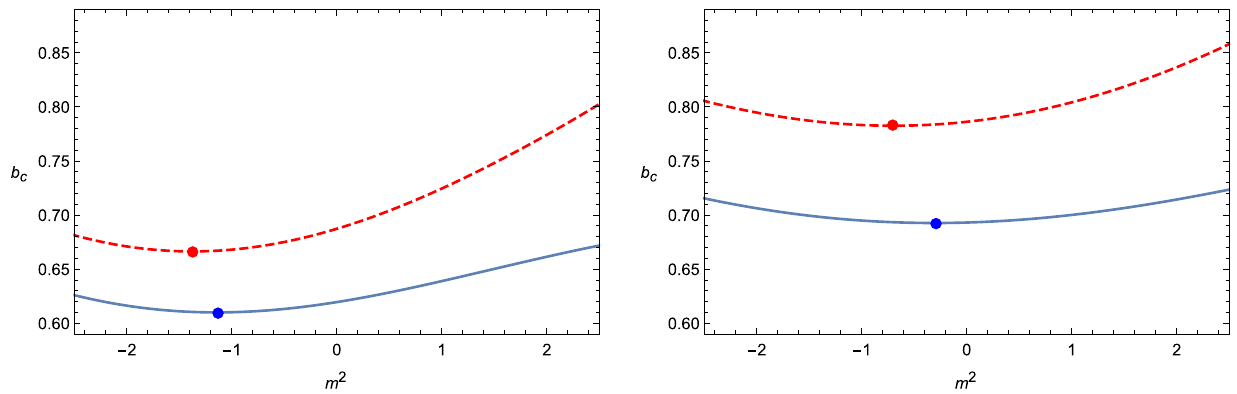
Fig. 2 b c − m 2 relations for m 2 p = 0 (left plot) and m 2 p = − 3 / 16 (right plot). The solid blue line denote the b c − m 2 relation for the p-wave solution and the dashed red line denote the relation for p + ip solution, with the points on each line indicating the location of the minimum